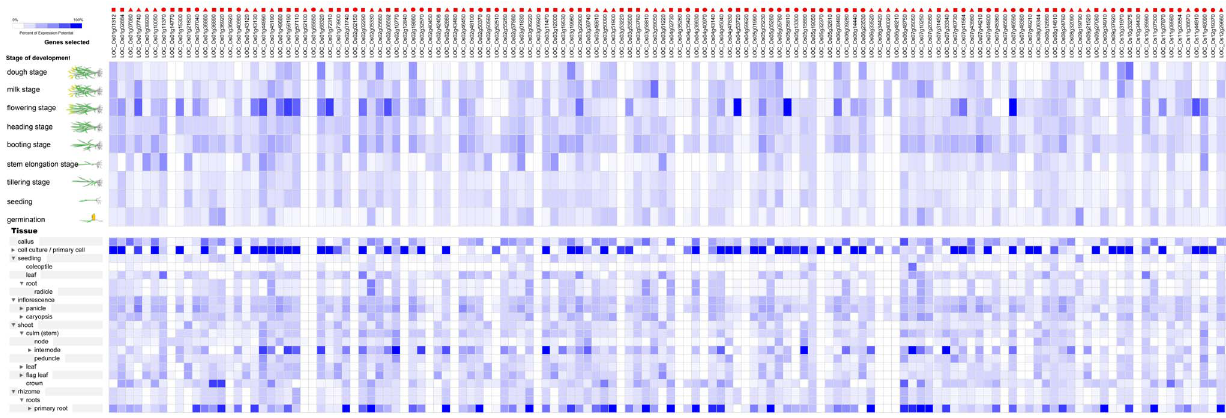
Figure 5. The expression profiles of 138 RNA helicase genes in Oryzasativa . The expression profiles of 138 RNA helicase genes in different development stages (above) and different tissues (below) in Oryza sativa . The deep and light blue shading represents the relative high or low percent potential expression levels, respectively, of the helicase genes in different development stages and different tissues. The DEAD-box, DEAH-box and DExD/H-box RNA helicase genes are indicated by the red triangle, circle and square, respectively.